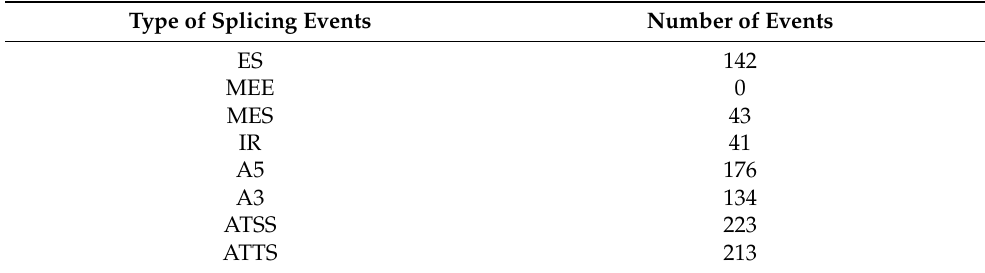
Table 4. Summary of detected AS events for switched isoforms according to different isoform usage. For each AS event the total number of events detected is